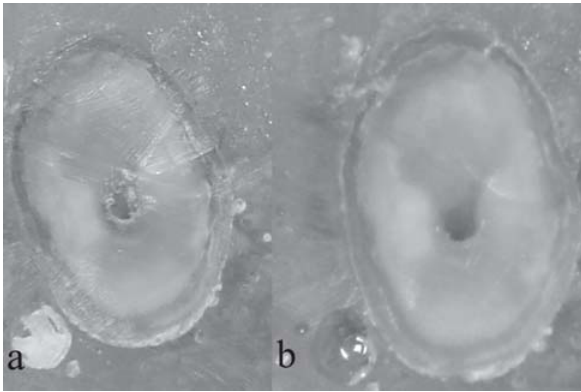
FIGURE 3- Apical third before (a) and after (b) preparation with RaCe system (Score 2)